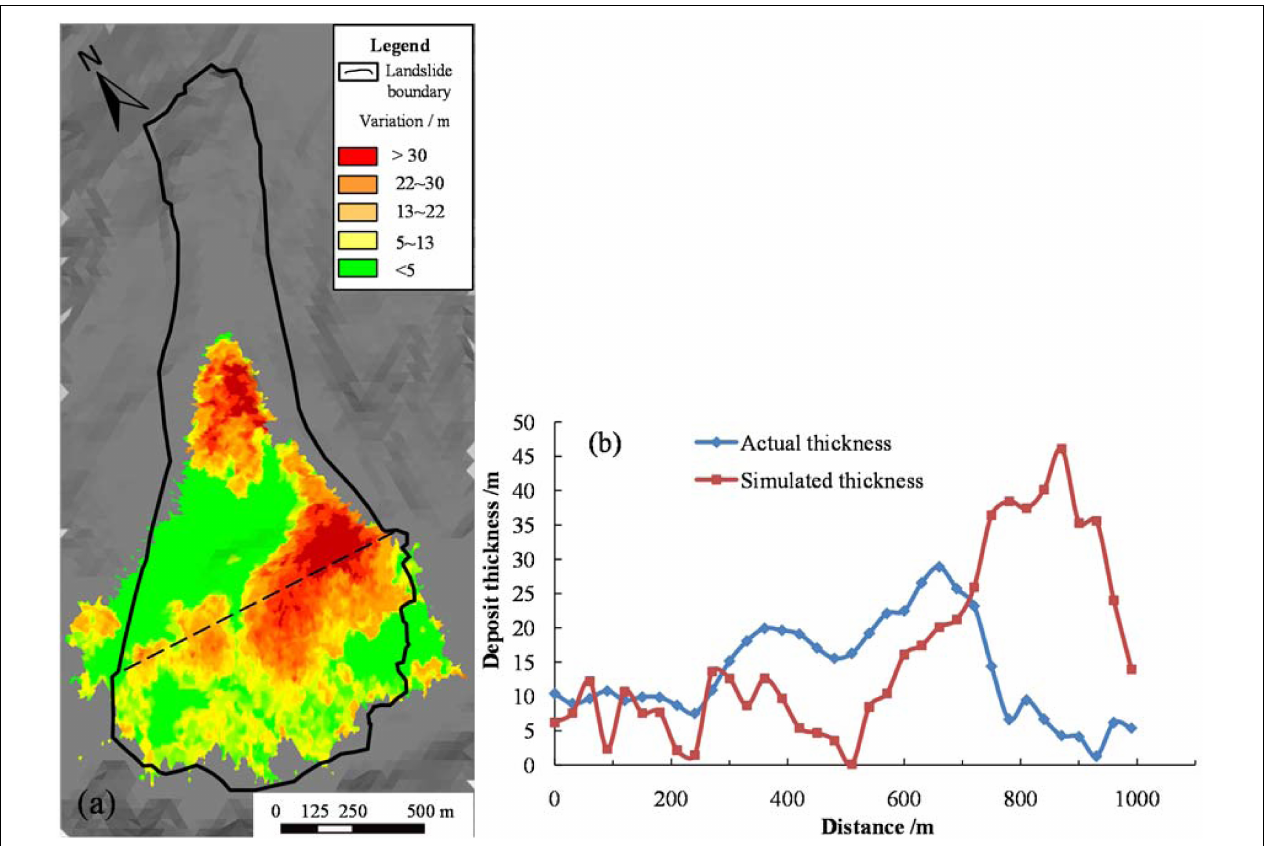
FIGURE 11 | Simulated deposit thickness distribution of the Xinmo Landslide. (a) the plan view and (b) simulated and actual thickness of the Xinmo Landslide deposit along a representative cross section which is shown in (a) as the dash